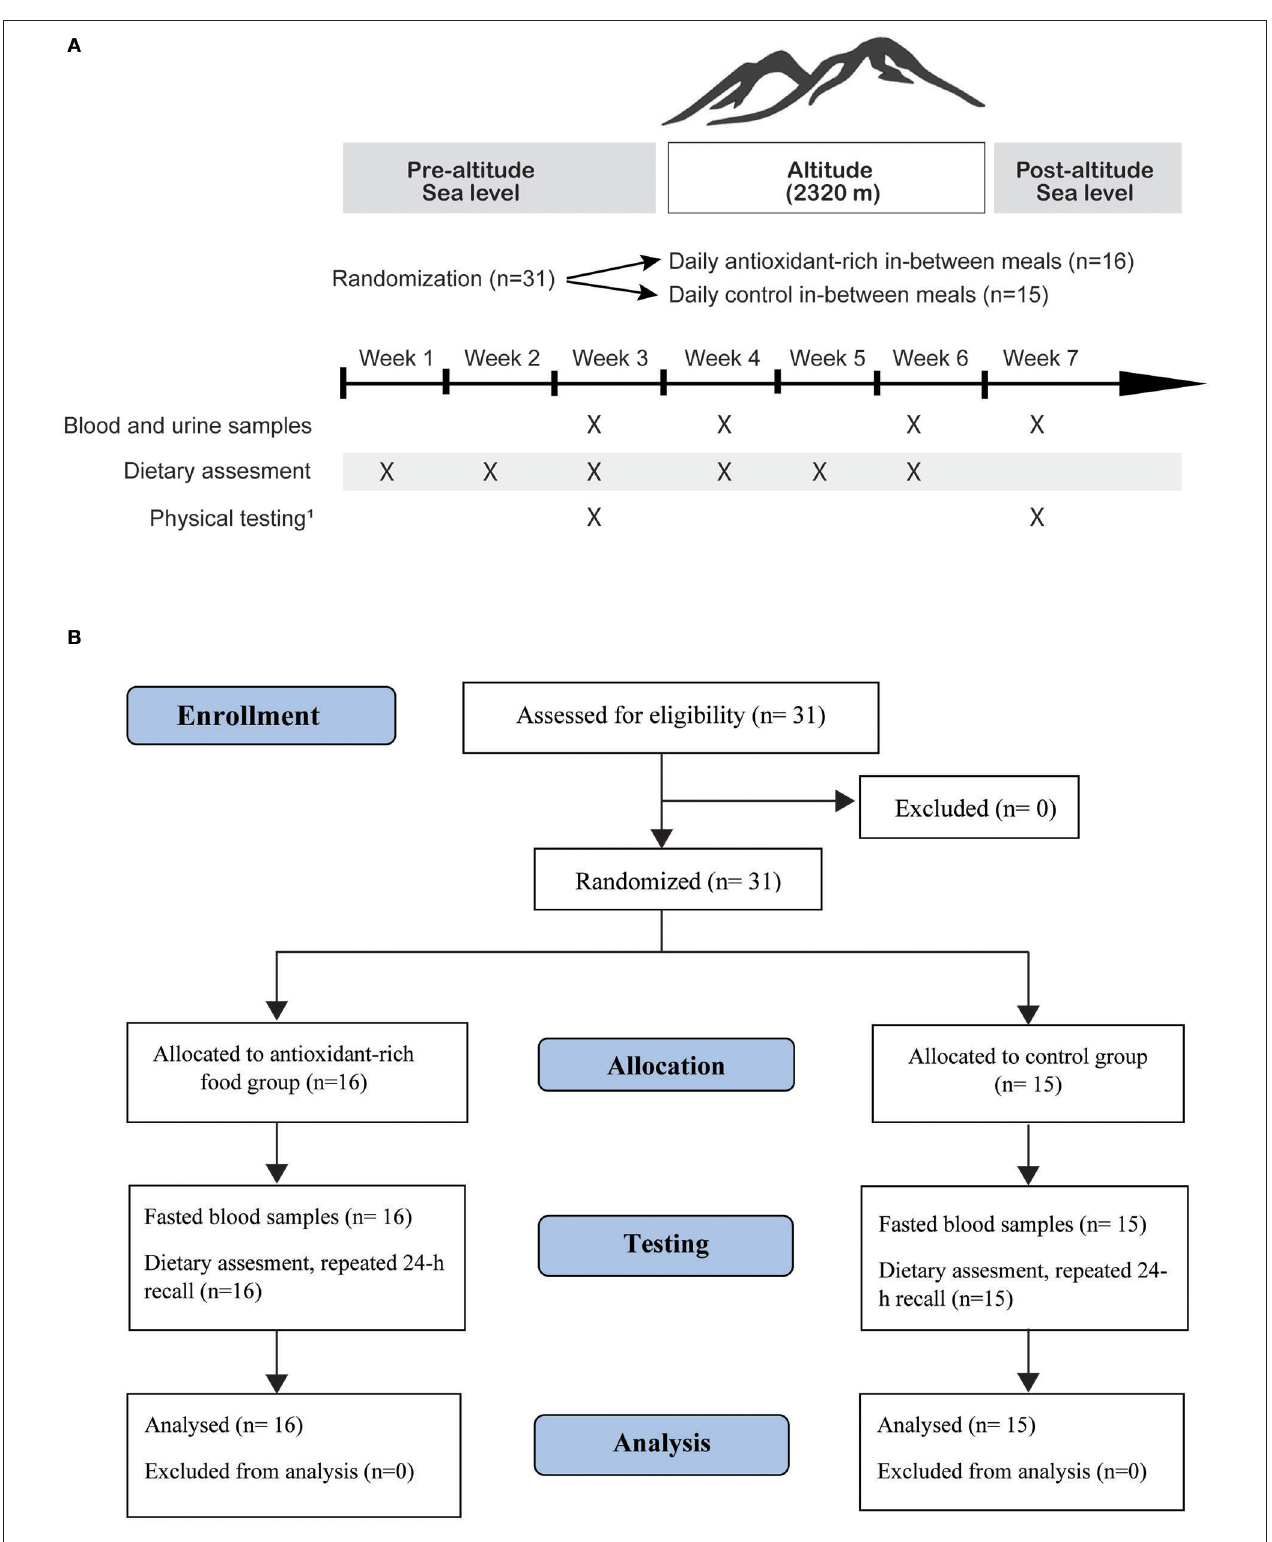
FIGURE 1 | Experimental design and timeline of testing before, during and after the 3-week altitude training camp at 2,320m above the sea level (A) , and Consort flow chart of the study participants (B) . 1 Includes DXA, VO 2max , hbmass, 100m swimming as previously described (Koivisto et al., 2018).